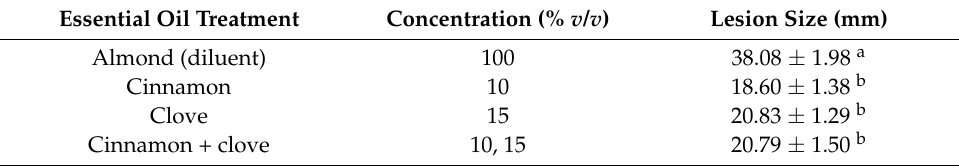
Table 3. Efficacy of essential oils in reducing the size of F. circinatum lesions in P. radiata . Essential oils were applied one day prior to infection with F. circinatum , and lesions were measured six weeks after the infection. Cinnamon and clove oils were diluted to the indicated concentration with sweet almond oil. Values shown are the means of 30 lesions ± standard error. Statistically significant ( p < 0.05) differences in lesion sizes among the treatments are indicated with a different lowercase